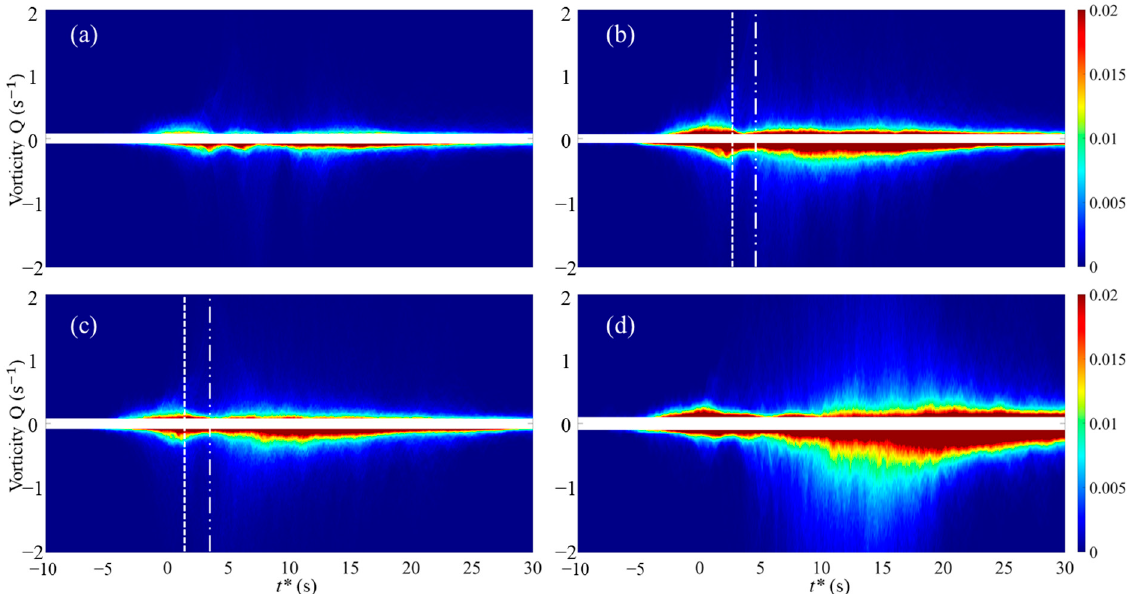
Figure 12. Time series of vorticity probability density distribution: ( a ) Run 75-4 (no internal hydraulic jump), ( b ) Run 75-6 (wavy internal hydraulic jump), ( c ) Run 75-8 (complete internal hydraulic jump) and ( d ) Run 180-8 (no internal hydraulic jump). The dashed line indicates time when internal hydraulic jump occurs, and the double dotted line represents time for occurrence of maximum breaking depth. Data between Q = [ − 0.05, 0.05] were eliminated for better comparison.